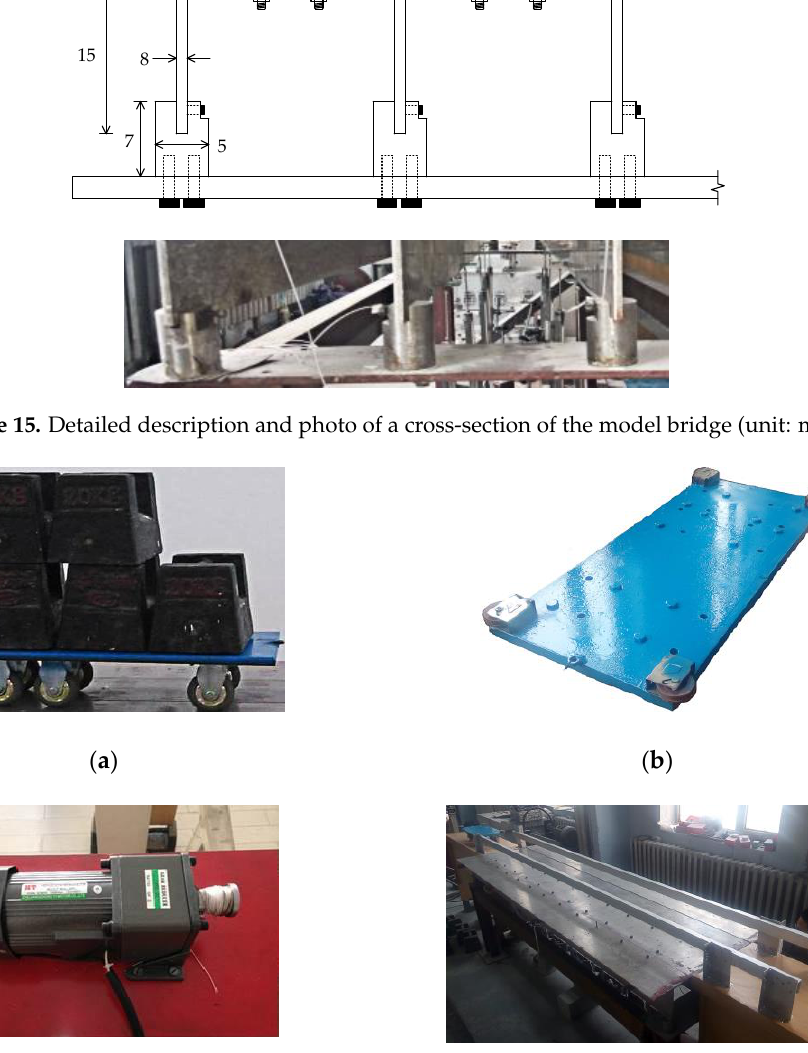
Figure 16. Photographs of the moving vehicle system: ( a ) clump weights; ( b ) steel vehicle; ( c ) electronic motor; ( d ) two aluminum tracks.